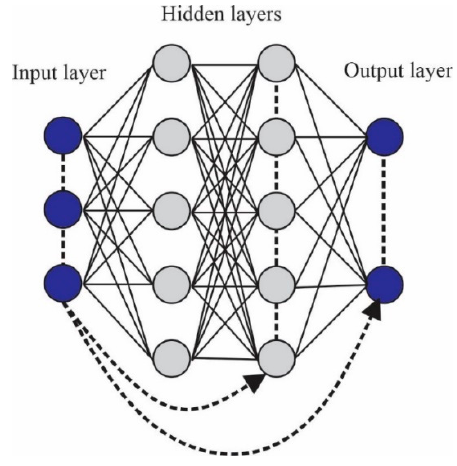
Figure 4. The typical architecture of a CFNN.